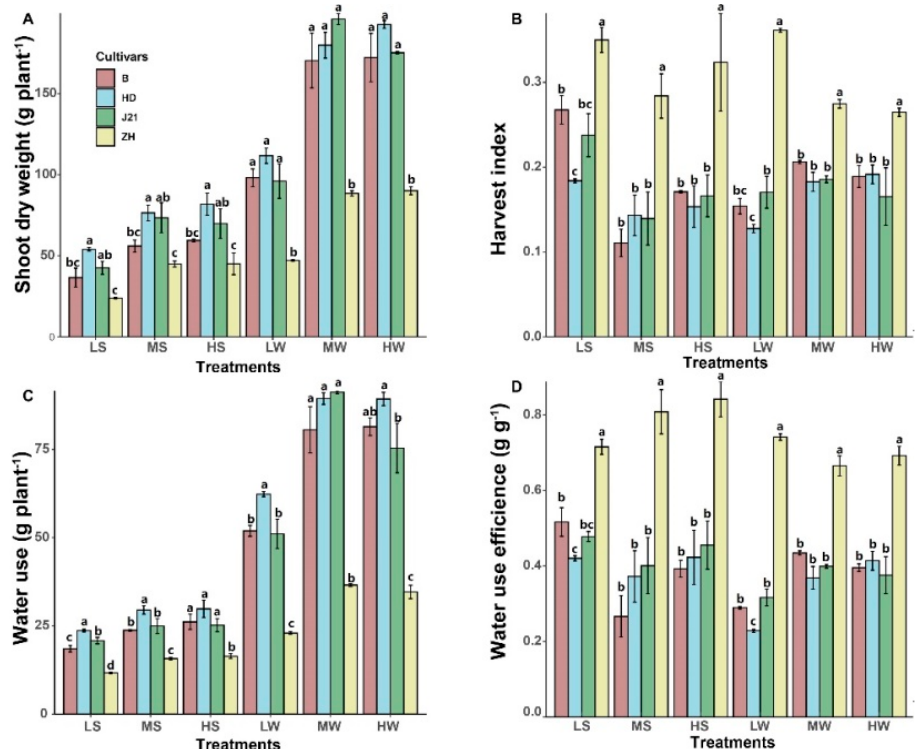
Figure 2. Shoot dry weight ( A ), harvest index ( B ), water use during the whole growth pe- riod ( C ), water use efficiency for grain yield ( D ) of four soybean genotypes [B (Bailudou), HD (Huangsedadou), J21 (Jindou 21), and ZH (Zhonghuang)] under two water treatments [S (cycle water stress), W (well-watered)] and three P levels [L, low P supply (P0), M, mid P supply (P60), H, high P supply (P120)]. The letters under each group of bars indicate different combinations of P and water treatments (as per Figure 1). Values are means plus one standard error of the mean ( n = 3).